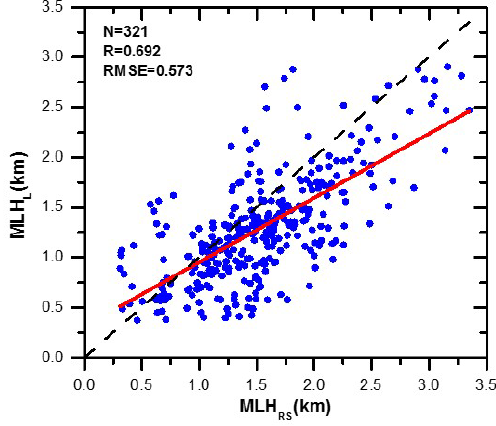
Figure 6. Comparisons between MLH L in summer derived from lidar and MLH RS from radiosonde at 14:00 (LST). The red line indicates the linear fitting of 321 samples, while the black dashed line represents the 1 : 1 line.